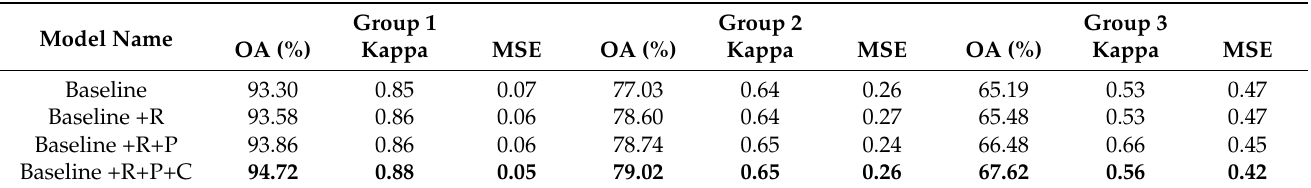
Table 9. The effects of different modules in EBDC-Net on the accuracy of building damage classifica- tion in the Yushu